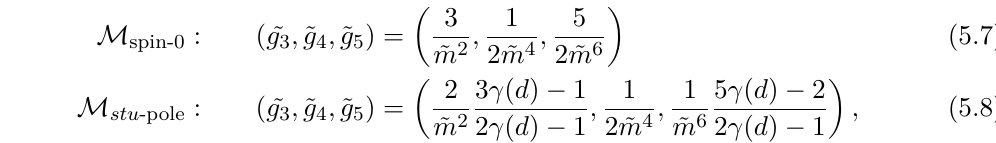
parameterization 2.6, it is straightforward to find